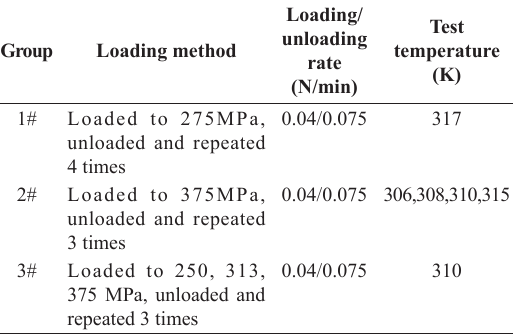
Table 1. Superelastic tests of Ni-Mn-Ga-Fe microwires.